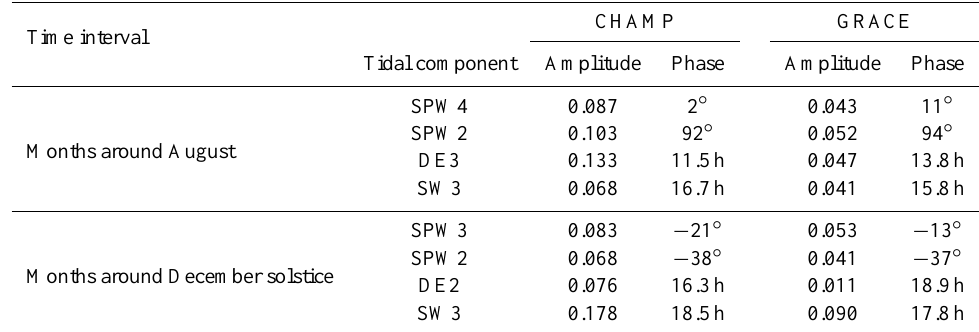
Fig. 9. The local time versus longitudinal distribution of the EIA parameter crest-to-trough ratio (CTR) from CHAMP (top) and GRACE (bottom) observations around August (left) and around December (right).